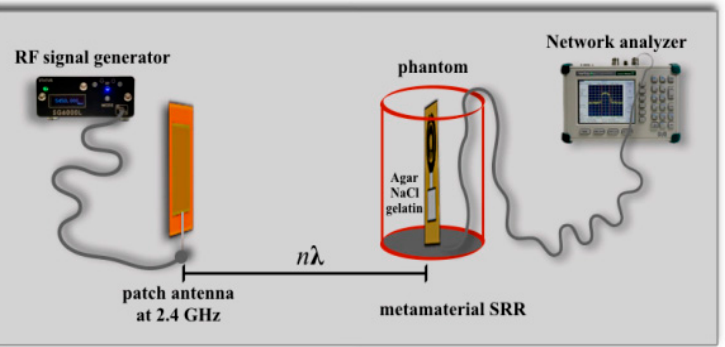
different frequencies to a metamaterial SRR within a cylinder filled with a solution to mimic human brain